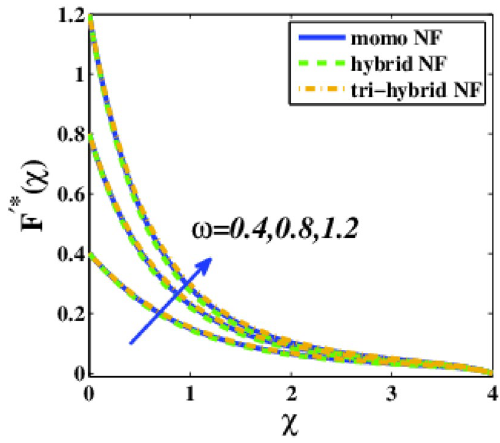
Figure 12. Control of ω on F ∗ ′ (χ) .